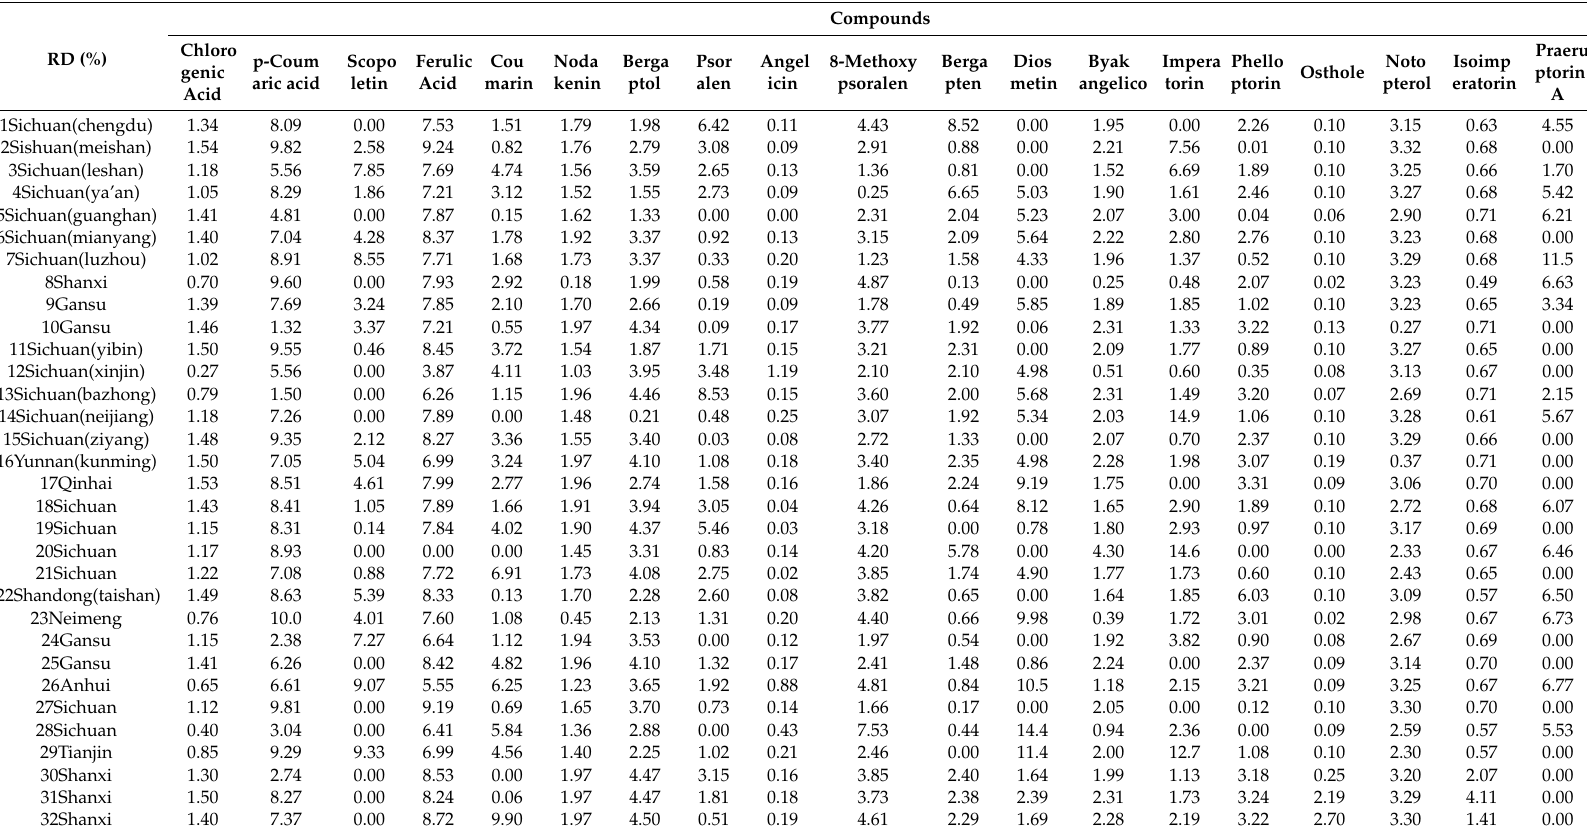
Table 7. The RD value from comparing the ES with the SSMD